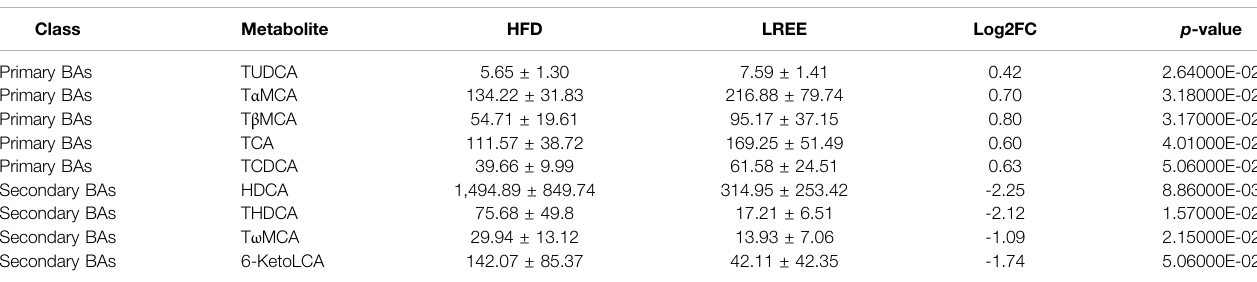
TABLE 4 | Differential bile acids between HFD groups and LREE treatment